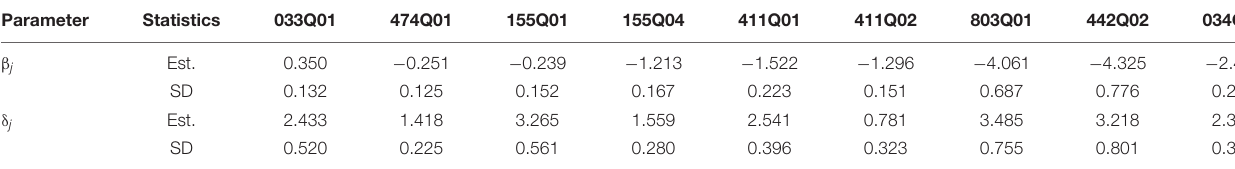
TABLE 9 | Estimates and standard errors of the item parameters for the real